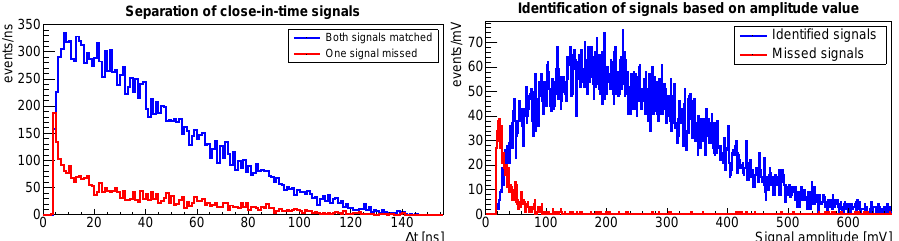
Figure 7. ( Left ) Matched (blue) and missed (red) events as a function of the arrival time difference ∆ t for events with two generated signals. ( Right ) Matched (blue) and missed (red) events as a function of the amplitude value for events with one generated signal. Missed events with high time differences are due to small